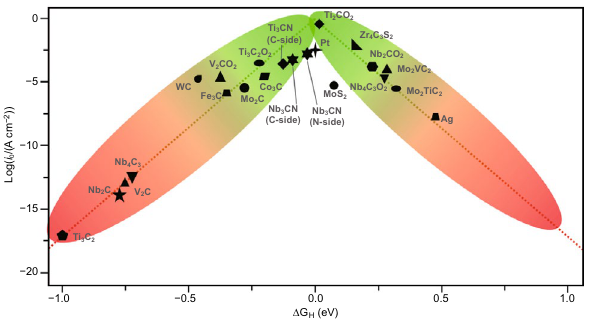
Fig. 9 Exchange current as the function of Gibbs free energy of hydrogen adsorption of